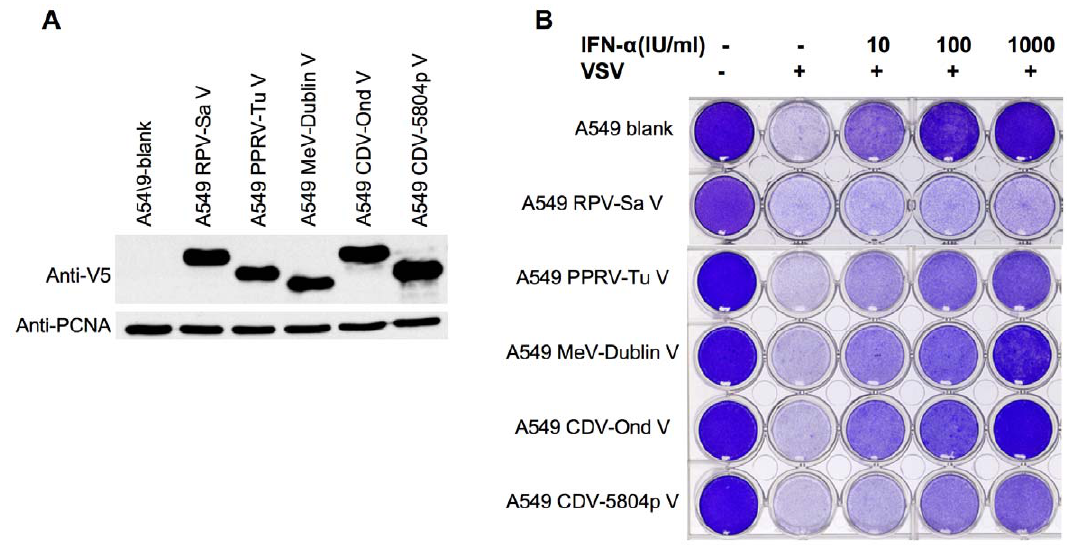
Figure 4. All four morbillivirus V proteins have the ability to block the induction of the type I IFN-induced antiviral state. (a) Demonstration of expression of different morbillivirus V proteins in the stable cell lines used for the VSV CPE functional assays. A549-blank and stable cell lines expressing the indicated proteins were plated in 24-well plates. Next day, cells were lysed in SDS-PAGE sample buffer and the expressed proteins were detected in Western blots using mouse anti-V5 antibody. PCNA levels served as loading control. (b) VSV CPE assay for the type I IFN- induced antiviral state. Stable cell lines expressing the indicated proteins were plated in 24-well plates. Next day, cells were mock treated or treated with 10, 100, 1000 IU/ml of IFN a for 24 hours. The cells were then challenged with VSV at a MOI of 0.1 for 24 hours (or left untreated), fixed and stained with crystal violet. Shown are results from one of three independent experiments.